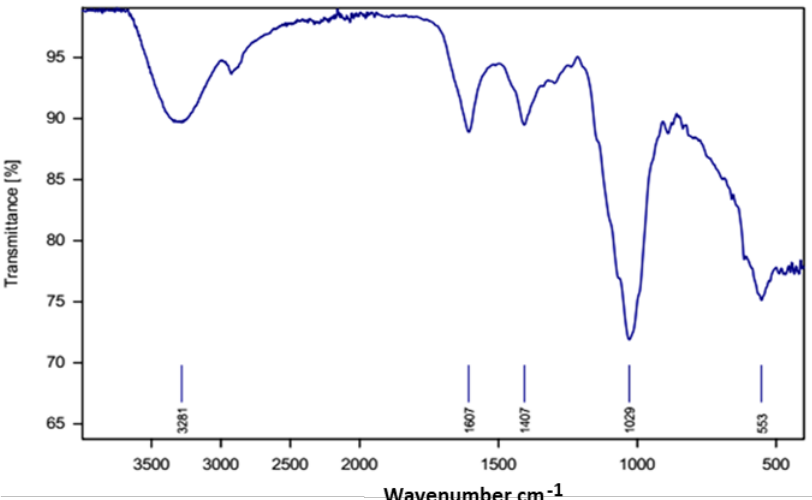
Figure 5. FT-IR spectrum of Delonix regia polysaccharide.